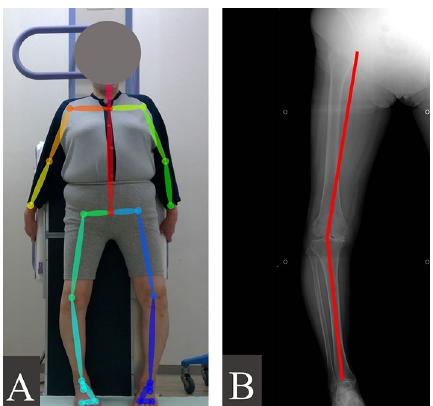
Figure 1. Images for hip-knee-ankle angle measurement. ( A ) OpenPose image. ( B ) Radiographic